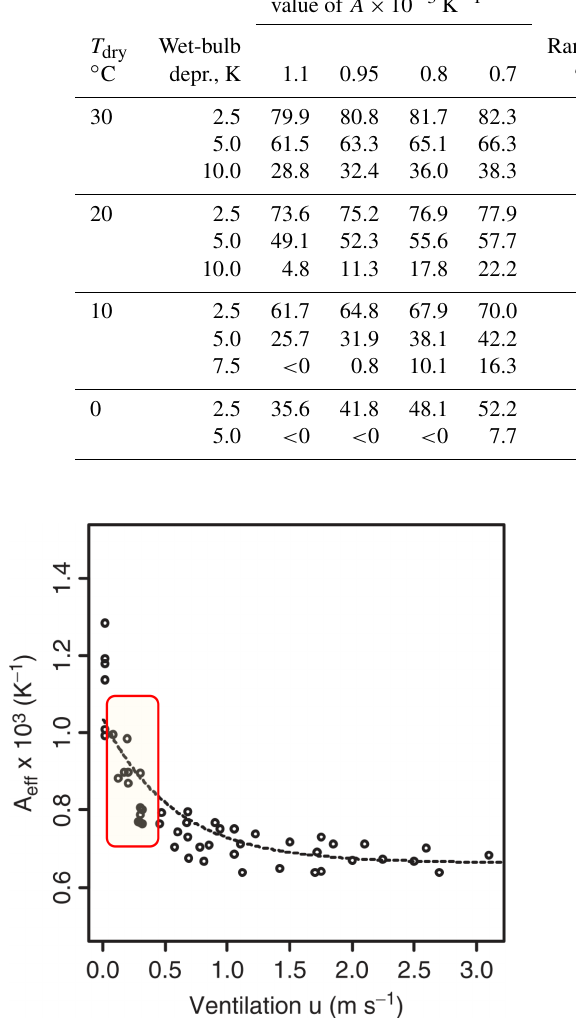
Figure 11. Dependence of the psychrometer coefficient A on ventilation speed. Figure is adapted from Fig. 6.18 of Harrison (2014). The shaded box overlay shows the 5% and 95% percentile limits of screen airflow observed during this